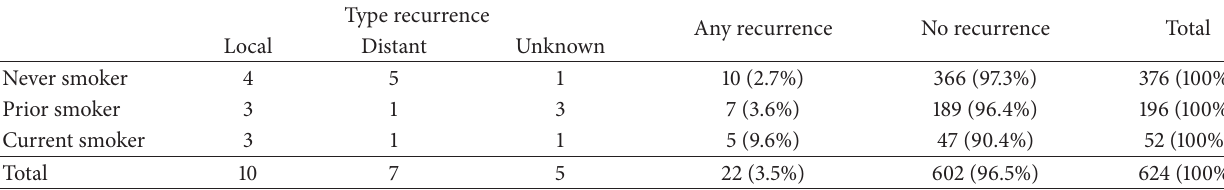
Table 2: Recurrence by smoking status.